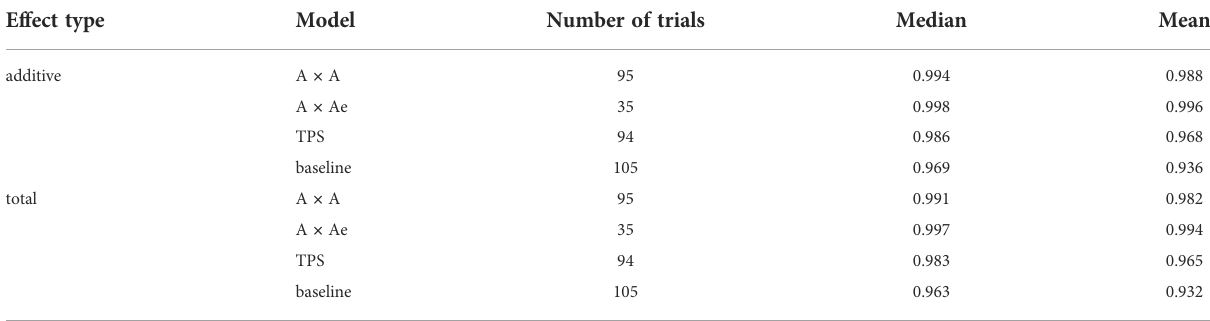
TABLE 3 Median and mean correlation between the e-BLUPs of the additive and total genetic effects for the A×A, A×Ae, TPS and baseline models and those for the best model for each trial. Effect